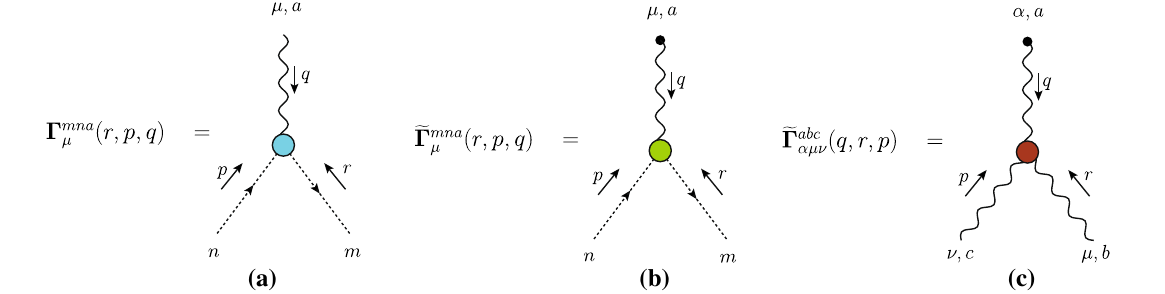
background three-gluon vertex (BQQ), with their respective momenta conventions. All momenta are incoming, q + r + p =